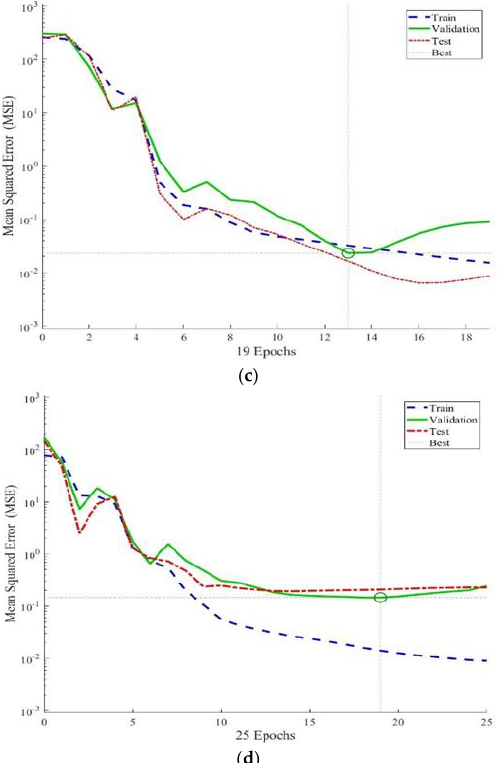
Figure 3. ( a ) The training performance graph of ANN model without heat generation effect. ( b ) The training performance graph of ANN model with heat generation effect. ( c ) The training performance graph of ANN model without radiation effect. ( d ) The training performance graph of ANN model with radiation effect.